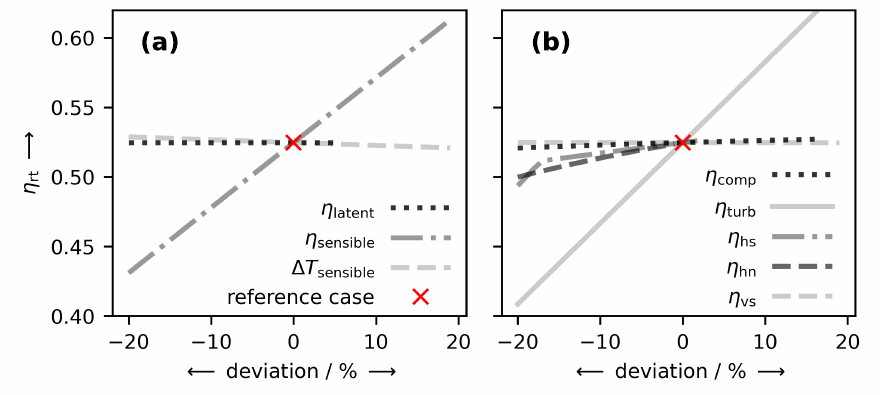
Figure 5. Sensitivity of the RTE to ( a ) heat storage and ( b ) other parameters with respect to a deviation from the reference case. The reference case (red cross) corresponds to the parameters of Table